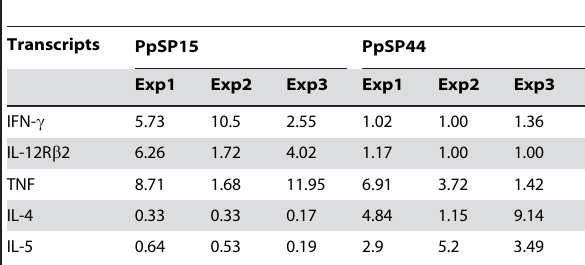
Table 1. Fold change in signal intensity of gene expression of inflammatory transcripts two hours following challenge with